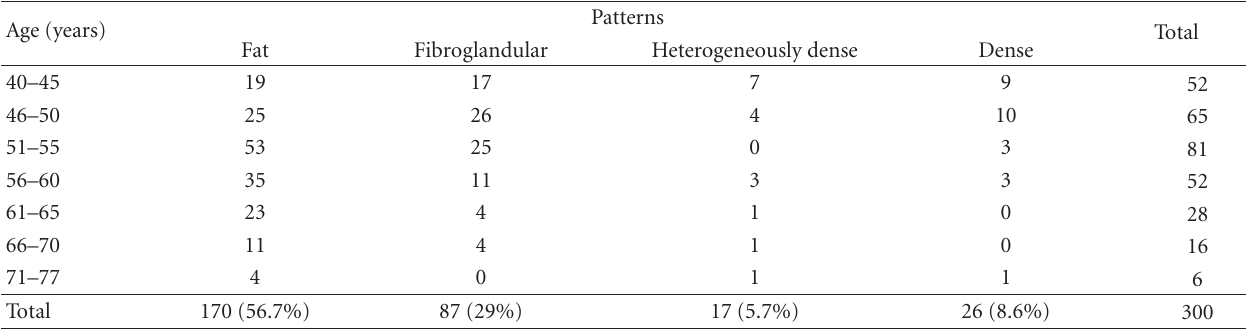
Table 3: Breast density, and age distribution.